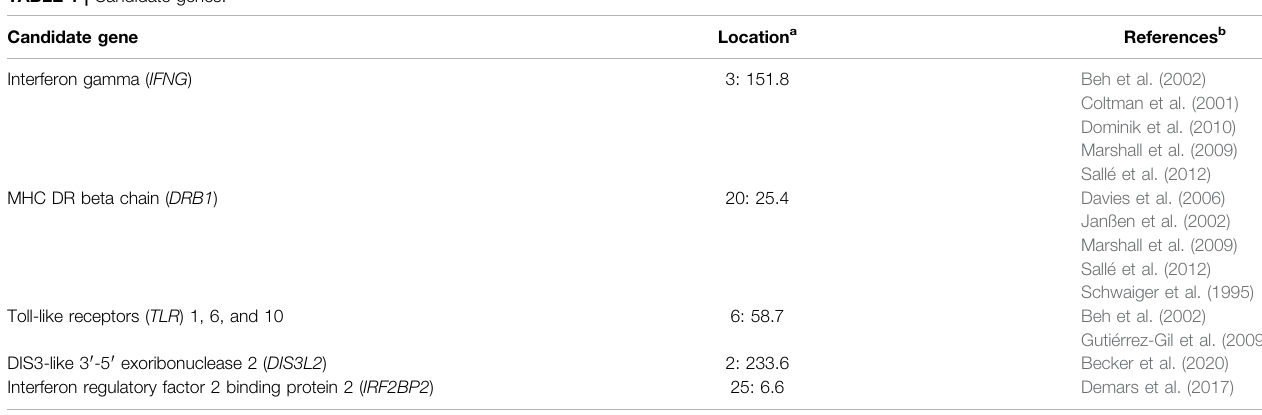
TABLE 1 | Candidate